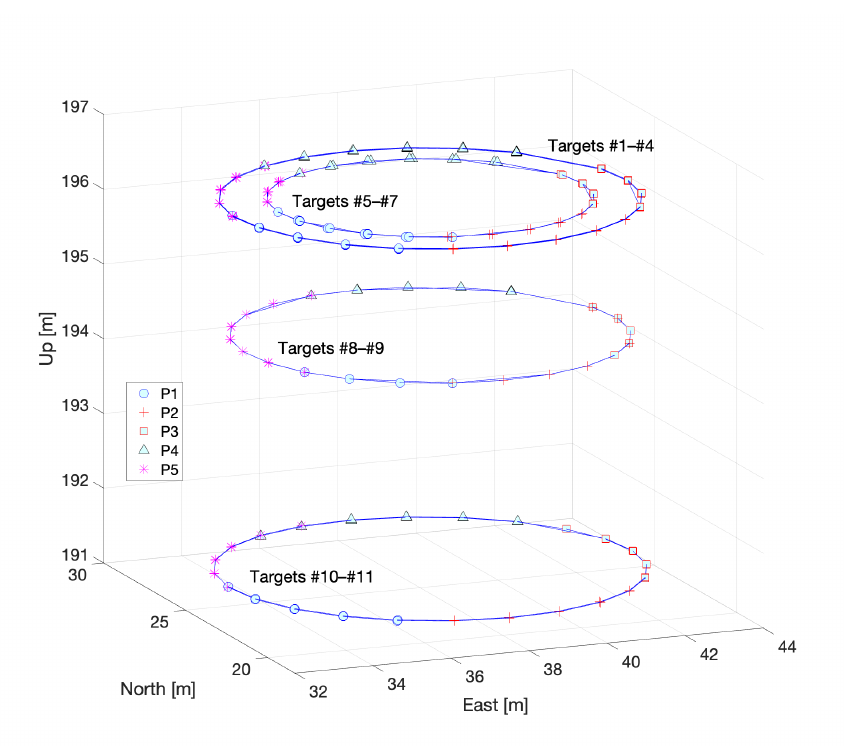
Figure 6. The trace of azimuthal rotation of targets. Each symbol represents the related pillars (P1 to P5) on which the instrument was installed for ground surveying.